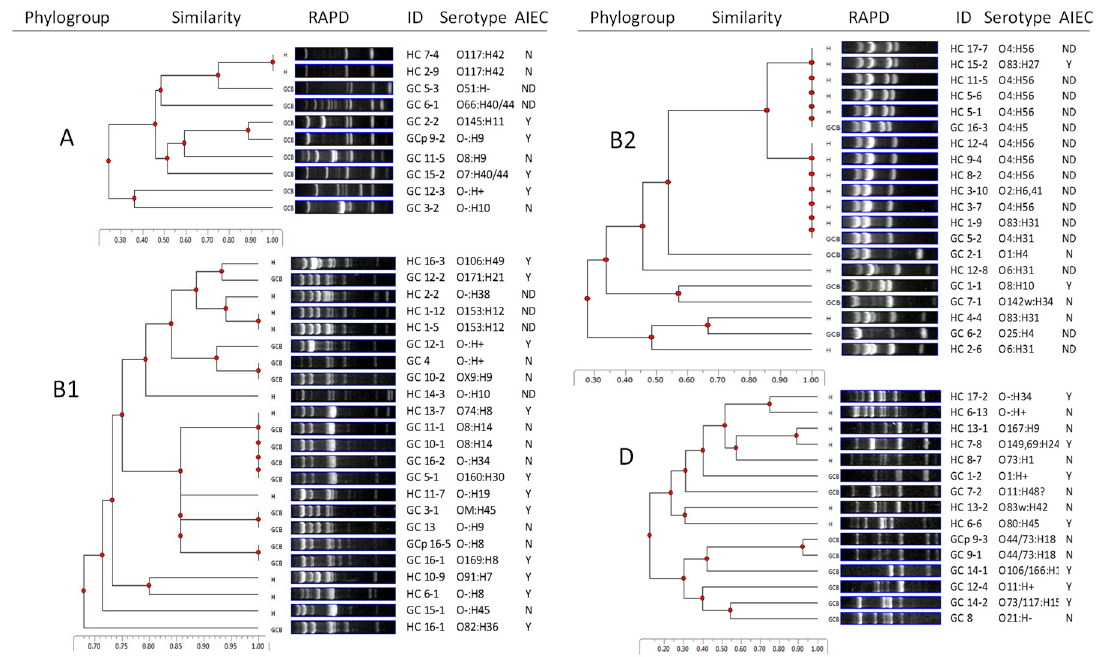
Figure 1. Relatedness of granulomatous colitis (GC) and healthy control (HC) E. coli according to the phylogroup and random amplified polymorphic DNA (RAPD) genotypes. Dendrograms were constructed for each phylogroup (A, B1, B2, and D) using TotalLab CLIQS software. Similarity values were generated for all pairwise comparisons. Serotype and adherent ‐ invasive E. coli (AIEC) (Y/N) were indicated for each strain. Not determined (ND), since the E. coli strains were either cytotoxic or gentamicin resistant.